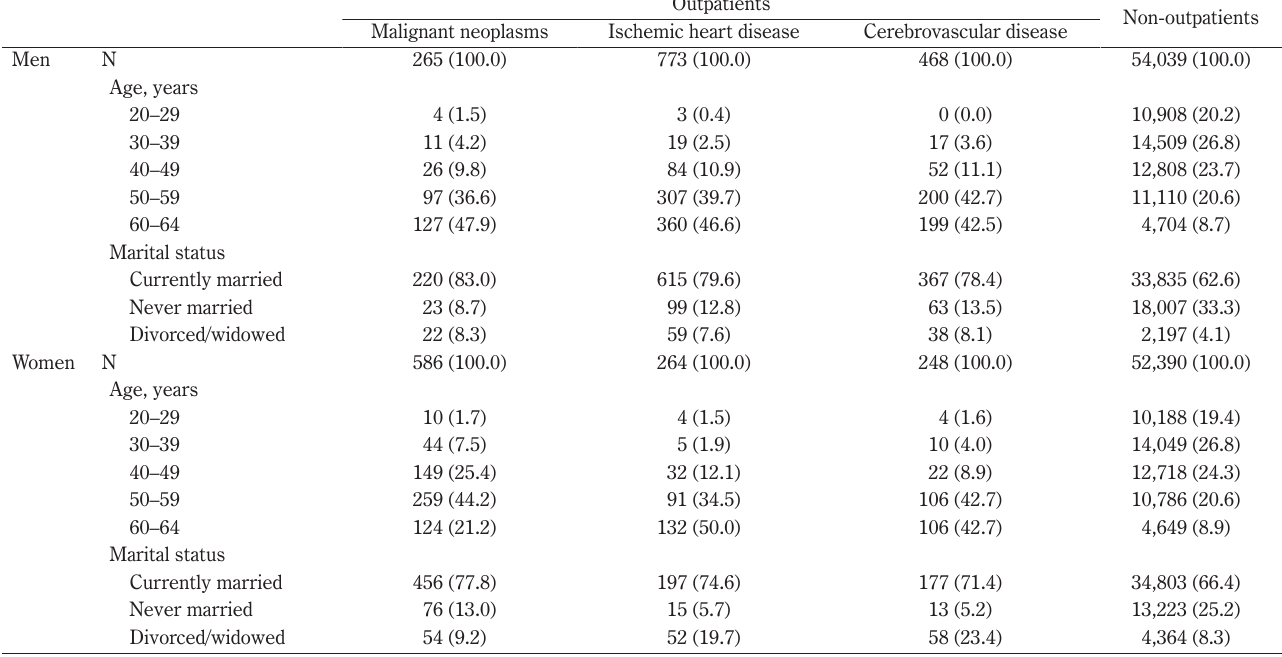
Table 1 Distribution of age and marital status in outpatients with malignant neoplasms, ischemic heart disease, and cerebrovascular disease, and non-